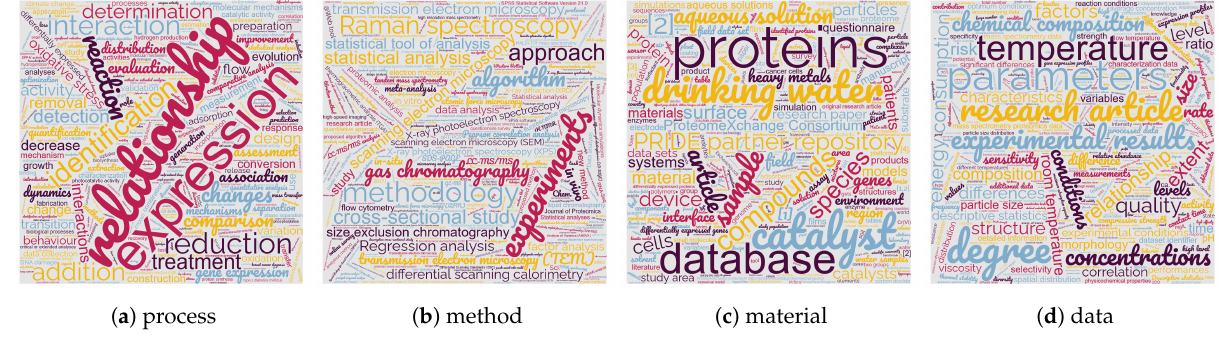
Figure 4. Chemistry domain word